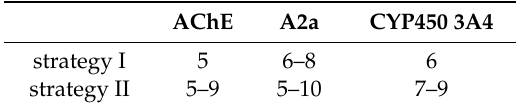
Table 3. Complexity (number of features) of pharmacophore